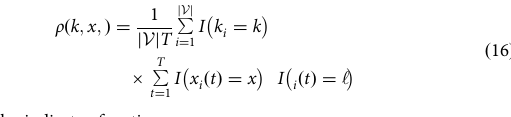
complex and interacting contagion dynamics, sample uniformly the number